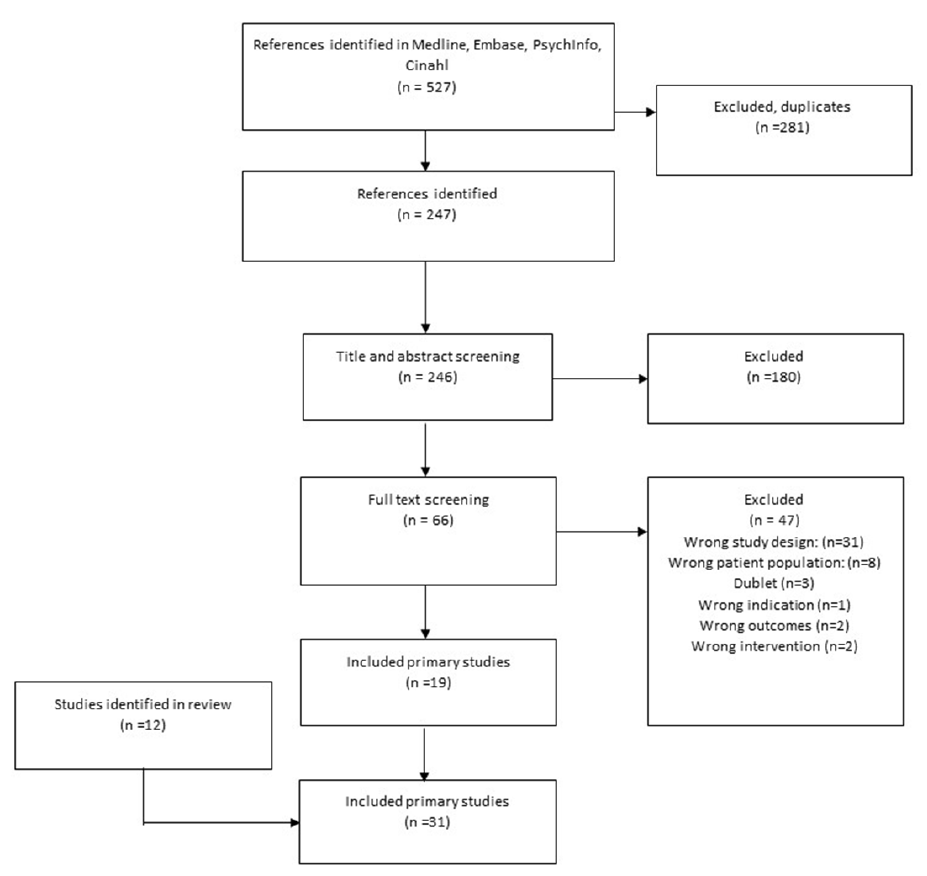
Figure 2. Flowchart of the search for primary studies in 2017 and